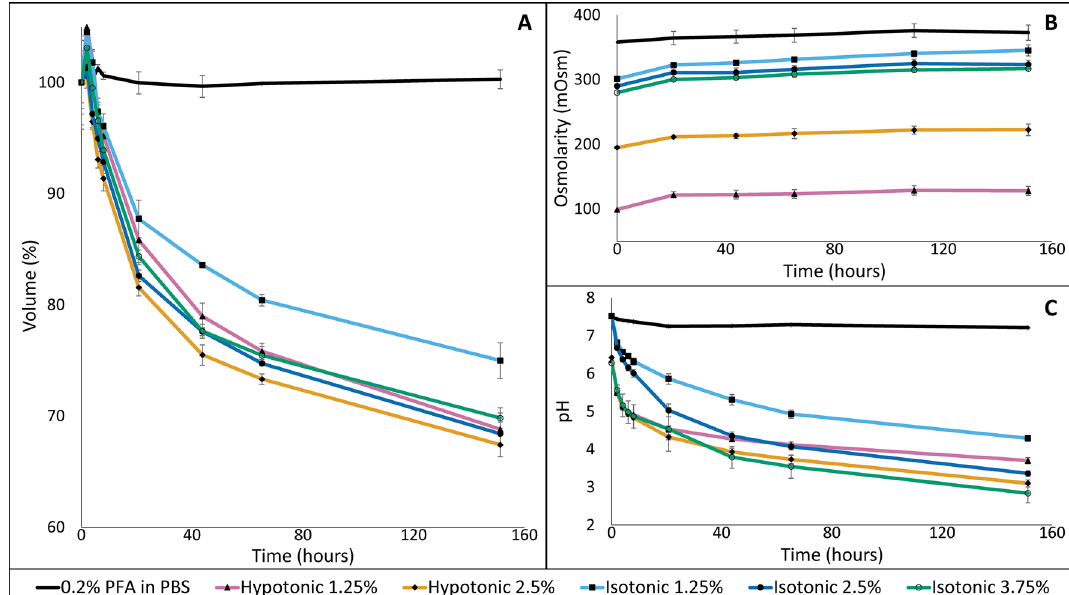
Figure 2. Mouse livers stained in different Lugol’s solutions. Mouse livers were stained in Lugol’s solutions that differed with respect to Lugol concentrations and tonicities. Observed liver volumes were normalized by setting the mean volume at time 0 to 100%. All presented values are the average and standard deviation of three different livers. ( A ) Liver volume. Liver volume remained stable in the control samples, with an